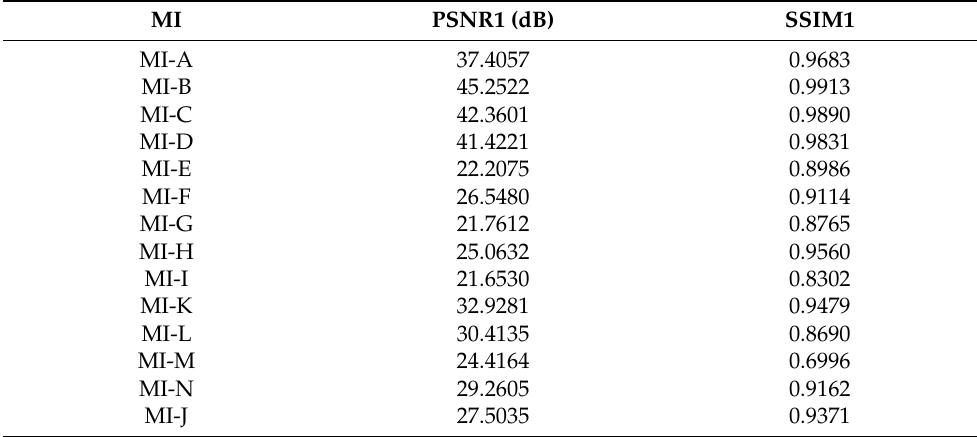
Table 1. Quality Objective Metrics.